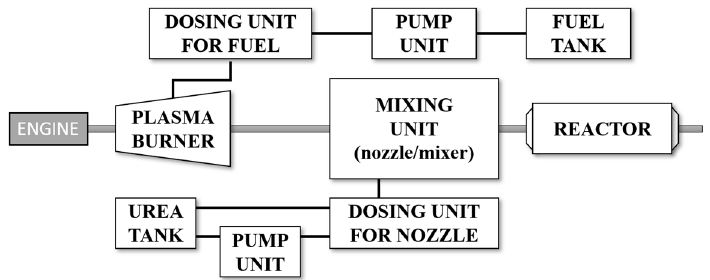
Figure 3. Schematic drawing with actual behavior.